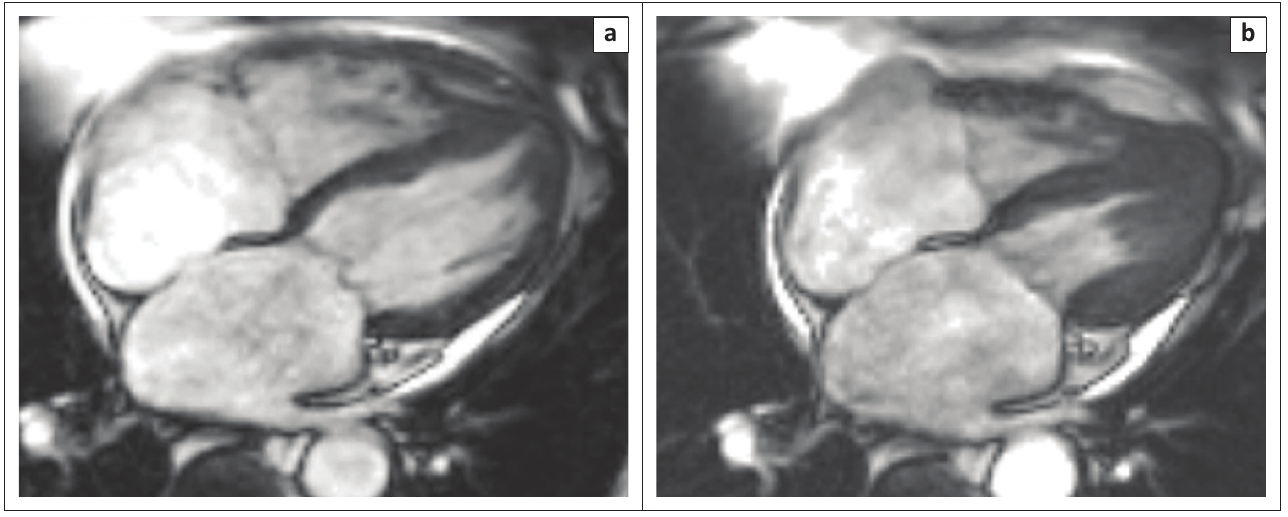
FIGURE 3: Relative apical hypertrophy. Here, the normal tapering of wall thickness to the apex is absent and the maximum thickness is greater than that at the base. Also note the biatrial dilatation. Shown are the end diastolic frame (a), and the end systolic frame